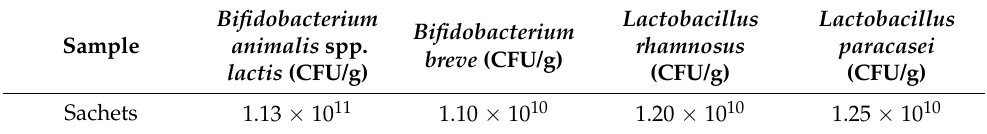
Table 4. Results obtained from plate count method of food supplement